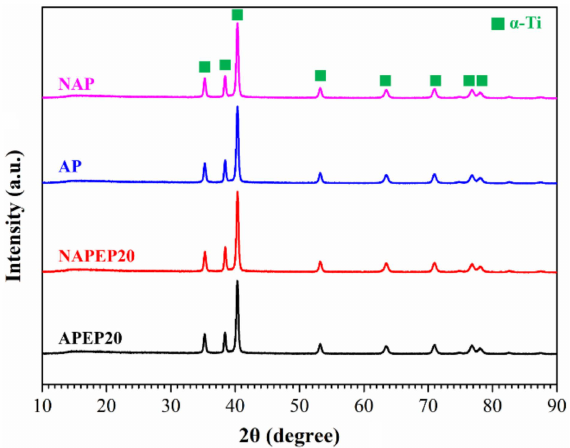
Figure 8. The XRD results of the NAP, AP, NAPEP20 and APEP20